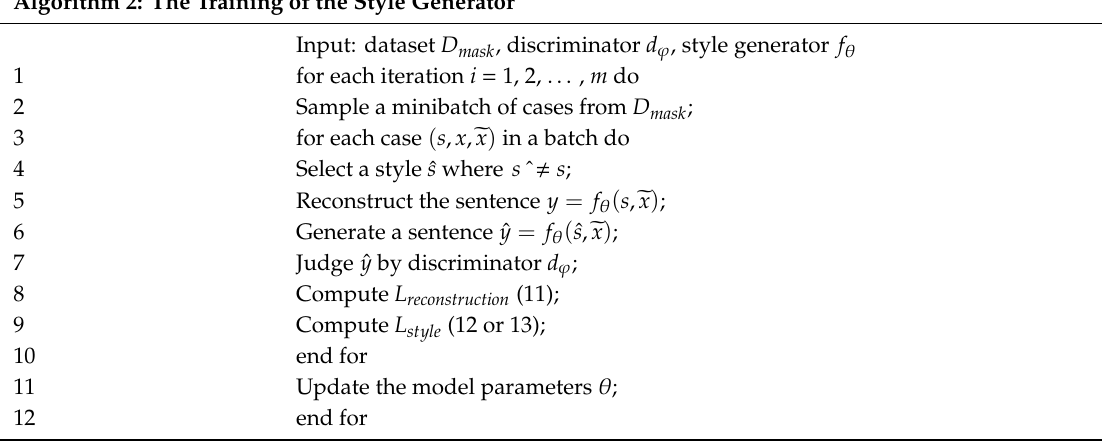
Algorithm 2: The Training of the Style